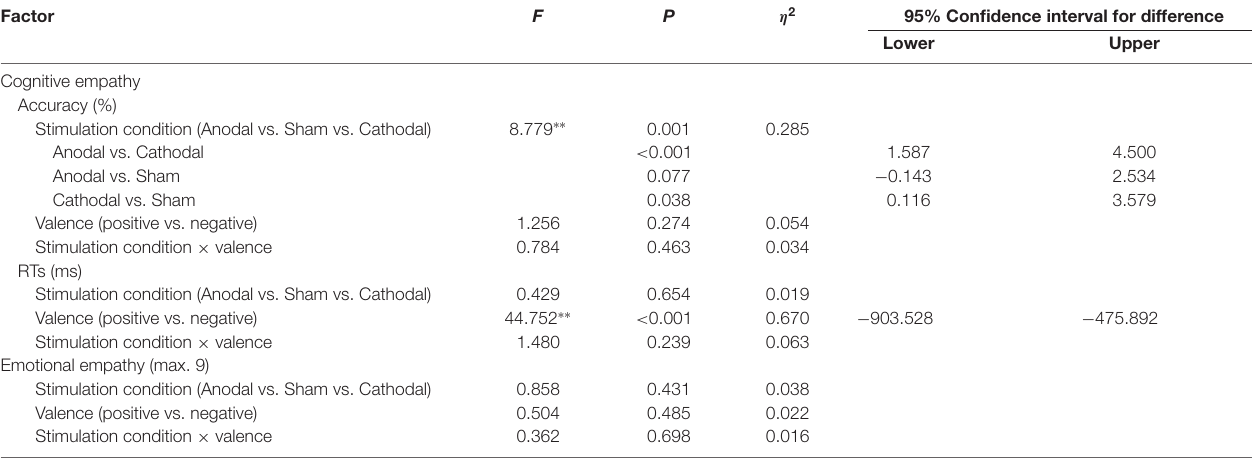
TABLE 2 | Repeated-measures ANOVA on the accuracy and response times (RTs) of cognitive empathy and average ratings of emotional empathy derived from different stimulation conditions and